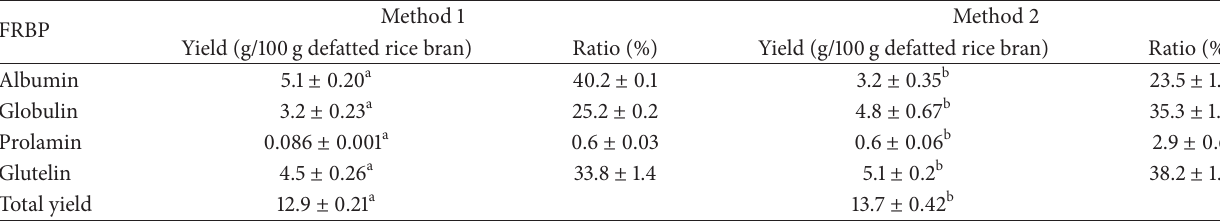
Table 1: Effect of extraction methods on the yield of FRBP ( 𝑛 = 3 ) a .